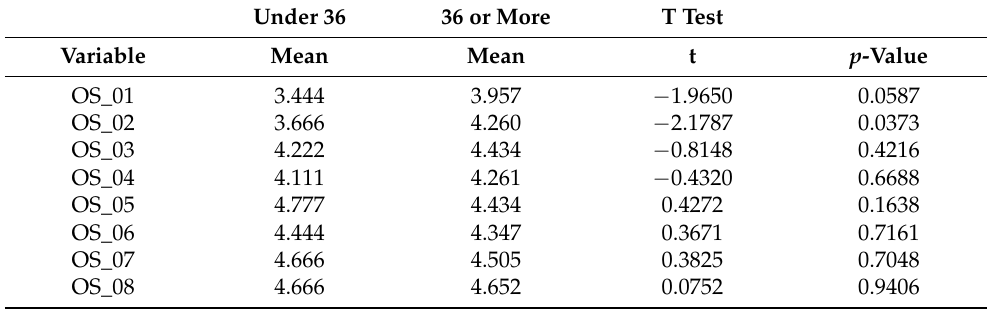
Table 9. Overall satisfaction by age.